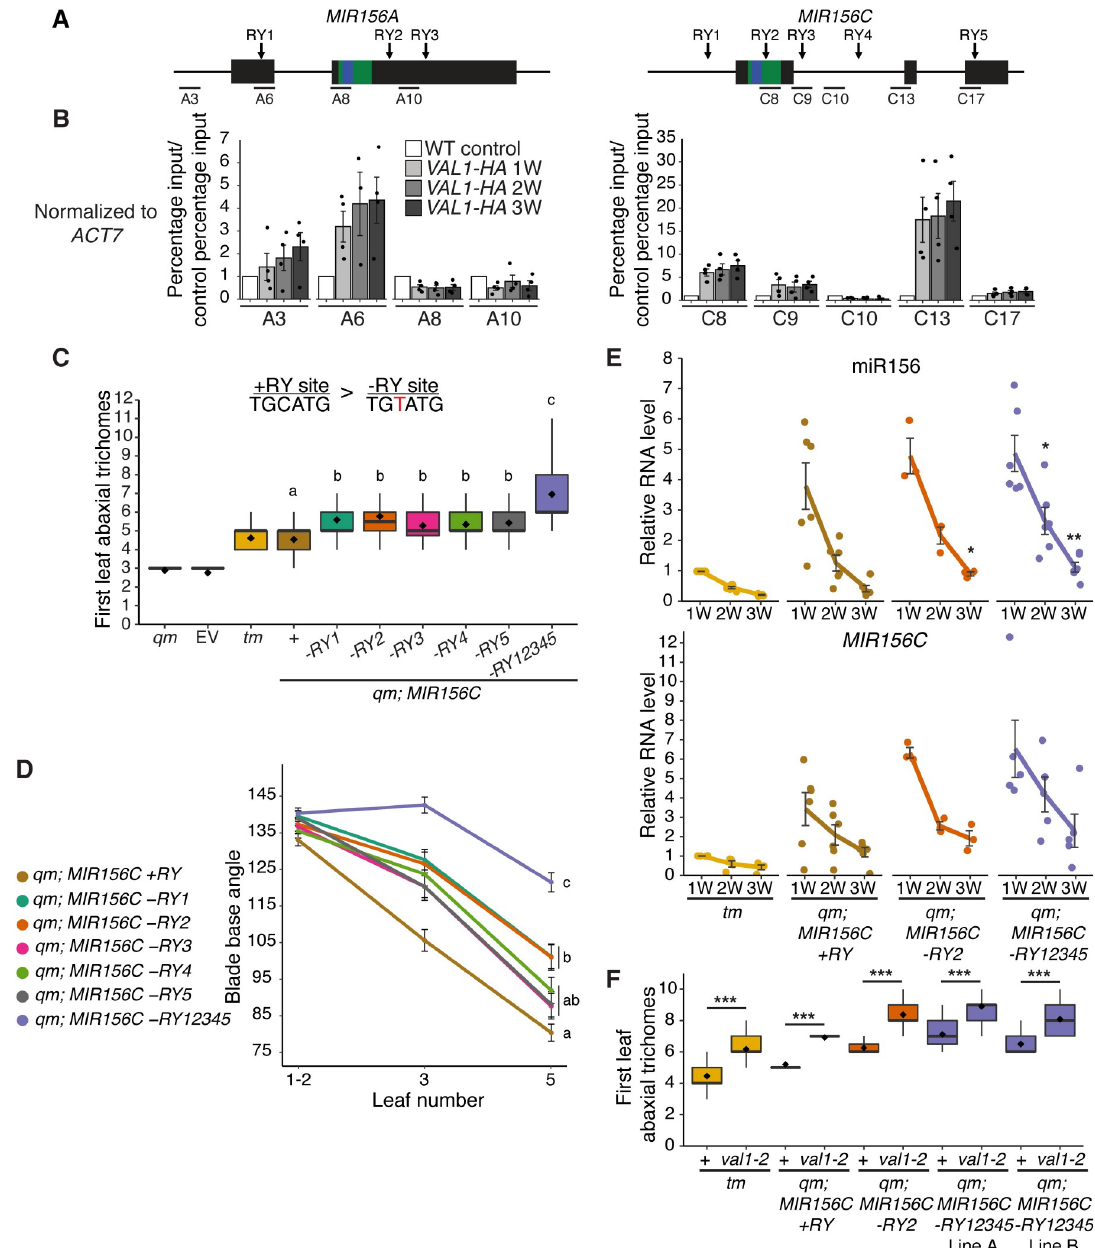
Fig 4. Loss of RY VAL-binding motifs at the MIR156C locus delays vegetative phase change. (A) Schematic depicting the location of primers used for ChIP-qPCR, the sequences encoding the miR156 hairpin and mature miRNA are coloured green and blue respectively. (B) Anti-HA ChIP-qPCR of WT Col control plants at 2W and VAL1 :: VAL1-HA; val1-2; FRI-Sf2 plants at 1, 2 and 3W of growth. The data is presented as percentage input normalized to ACT7 and is displayed relative to WT. Each data point represents a biological replicate and is the average of three technical replicates, bars represent the mean and error bars the mean ± s.e.m. (C, D) Phenotypes of T1 plants transformed with MIR156C RY variants. Statistically distinct genotypes were identified by one-way ANOVA with post hoc Tukey multiple comparison test (letters indicate statistically distinct groups P < 0.05; comparison in (D) made at leaf 5). qm = mir156a mir156c mir157a mir157c quadruple mutant , tm = mir156a mir157a mir157c triple mutant , EV = empty vector. (D) Colored lines represent the mean and black bars the mean ± s.e.m. Sample size (C) 26–52, (D) 37–51. (E) qRT-PCR analyses of gene expression in shoot apices with LP � 1mm removed at 1, 2 and 3 weeks. Each data point represents an independent homozygous T3 line and is the average of three technical replicates. Colored lines represent the mean and black bars the mean ± s.e.m. Asterisks represent significant differences between qm; MIR156C and qm; MIR156C -RY lines at the same time point, calculated by an unpaired two-tailed t- test with a Bonferroni correction for multiple comparisons ( � P < 0.025, �� P < 0.005). (F) Genetic interaction between val1-2 and MIR156C